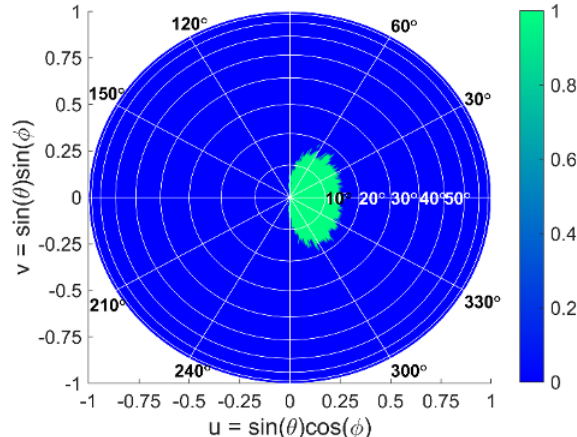
Fig. 2. The steering range projection onto a hemisphere for a circular array operating at 1550 nm wavelength. The bright green area corresponds to the set of all steerable angles with the sidelobe suppression larger than 10 dB, and the dark blue area represents non-steerable